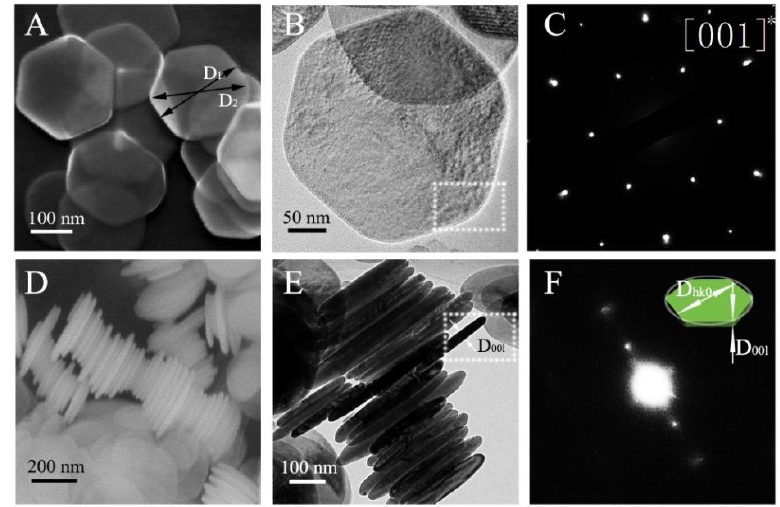
Figure 2. ( A ) SEM and ( B ) TEM images of Ni(OH) 2 nanoplates (top view), ( C ) SAED pattern of the square area in B, ( D ) SEM and ( E ) TEM mages of Ni(OH) 2 nanoplates (side view), and ( F ) SAED pattern of the square area in E (The inset in F is a schematic of a Ni(OH) 2 nanoplate showing the diameter of D hk0 and D 00l ).